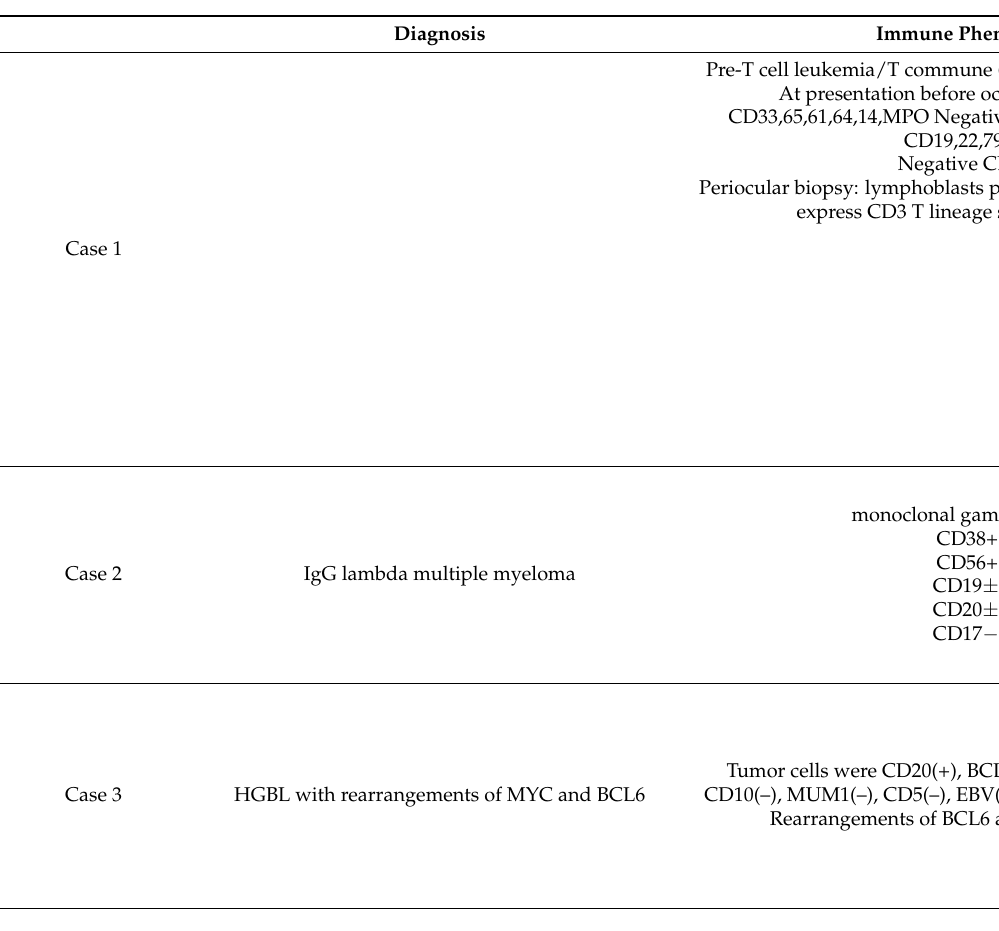
Table 1. Showing the 6 cases and their corresponding diagnoses, immune phenotypes, and